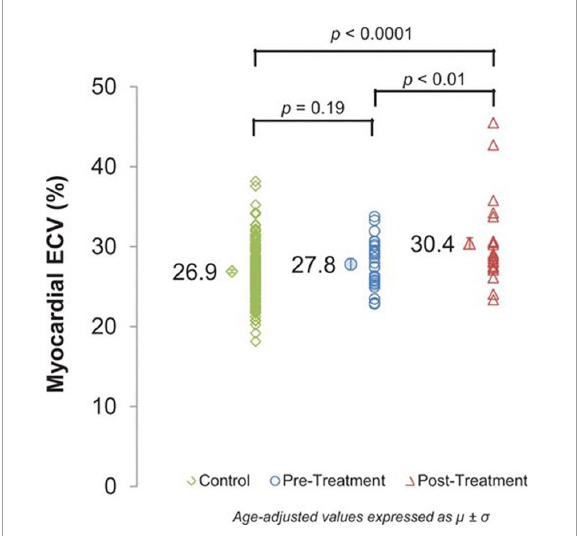
FIGURE9 Cardiovascular magnetic resonance (CMR) assessments of myocardial extracellular volume (ECV). Myocardial ECV measured by cardiovascular magnetic resonance in controls (26.9 ± 0.2%) and cancer pretreatment participants (27.8 ± 0.7%) compared with cancer survivors treated with anthracycline chemotherapy (30.4 ± 0.7%). ECV incrementally increases across the groups ( P < 0.0001) with a significant increase in